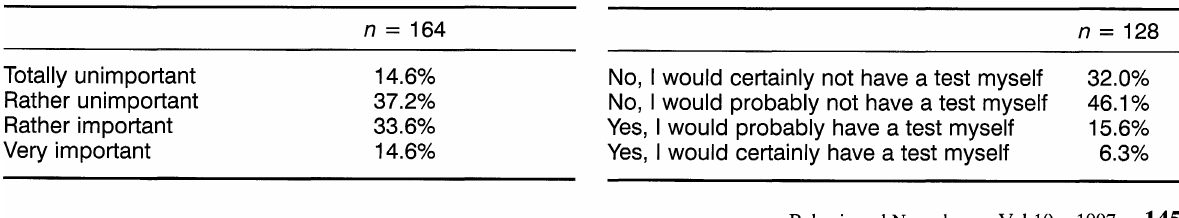
TABLE III. Personal intentions regarding a predictive test for